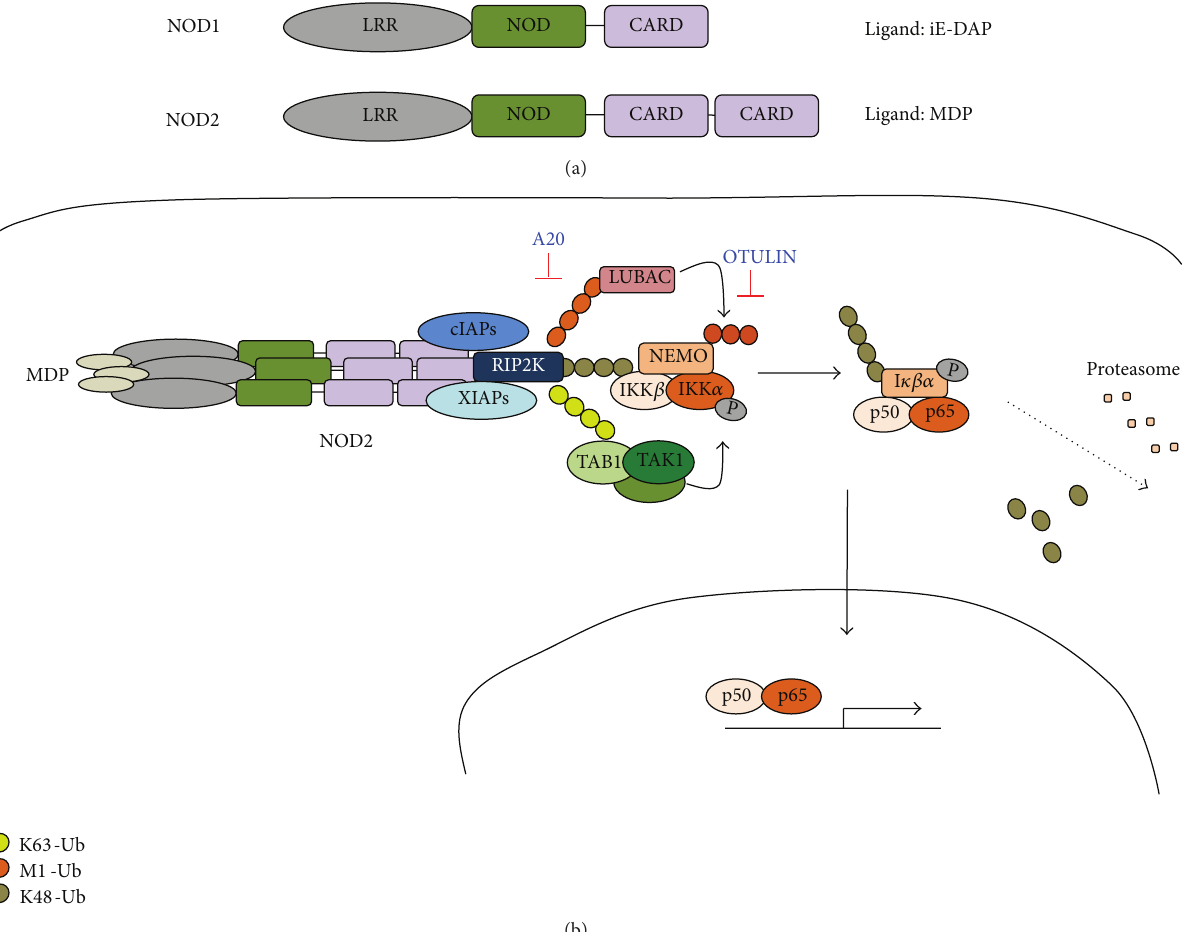
Figure 2: Regulation of NOD signalling by the ubiquitin-proteasome system. (a) NOD1 receptors recognize iE-DAP while NOD2 main ligand is muramyl dipeptide (MDP). (b) Similarly to NOD1, NOD2 receptors oligomerize upon ligand binding. This triggers the recruitment of RIPK2 to this complex and cIAP- and XIAP-mediated K63-ubiquitination of RIPK2. This allows the recruitment of TAK1/TAB2/TAB3 complex and LUBAC, which can also mediate the linear ubiquitination of RIPK2. TAK1 then phosphorylates IKK 𝛽 , which in turn phosphorylates I 𝜅 B and subsequently undergoes ubiquitination and proteasomal degradation. This frees NF- 𝜅 B (p50/p65) to translocate to the nucleus and initiate transcription. Deubiquitinases A20 and OTULIN are negative regulators of these events by deubiquitinating K63 and M1 poly-Ub chains,